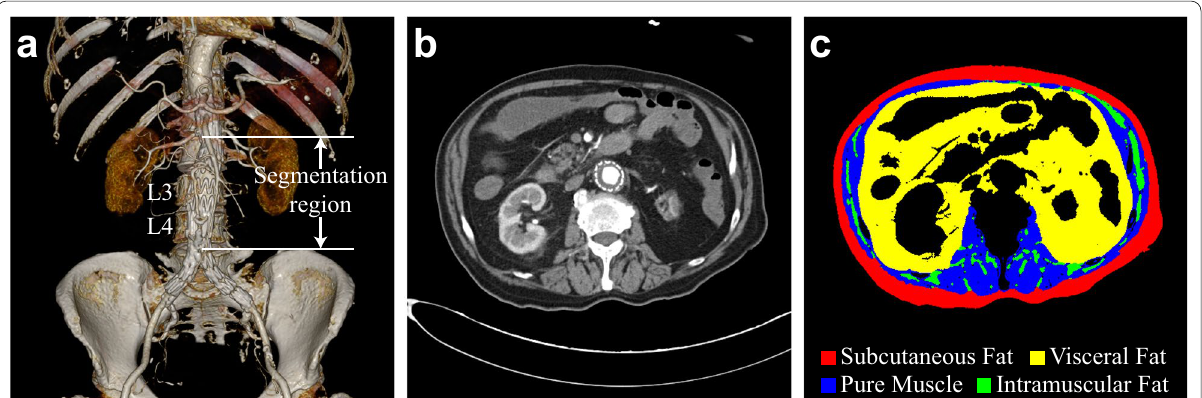
Fig. 3 Body composition segmentation. a The region of segmentation images (from the lower renal artery level to the upper edge of the iliac bone). b An original CT slice. c Body composition segmentation results of image